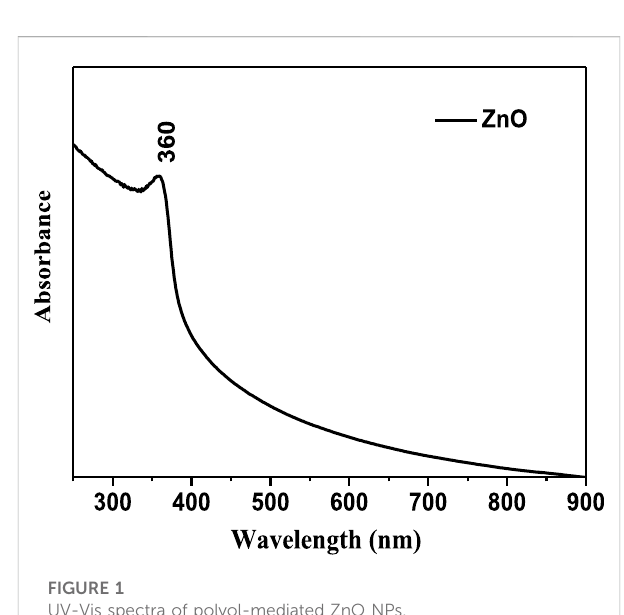
FIGURE 1 UV-Vis spectra of polyol-mediated ZnO NPs.